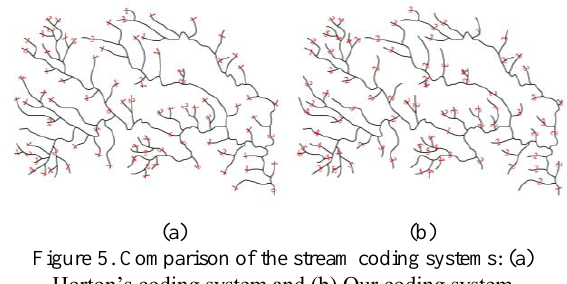
Figure 5. Comparison of the stream coding systems: (a) Horton’s coding system and (b) Our coding system The number of streams corresponding to each stream order, as provided by the aforementioned hydrologic coding systems, is shown in Table 1.